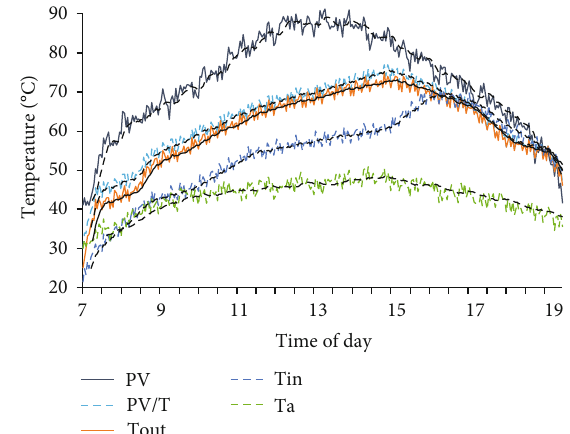
Figure 1: Measured daily dynamics of temperatures and their trend lines (21 July 2018).